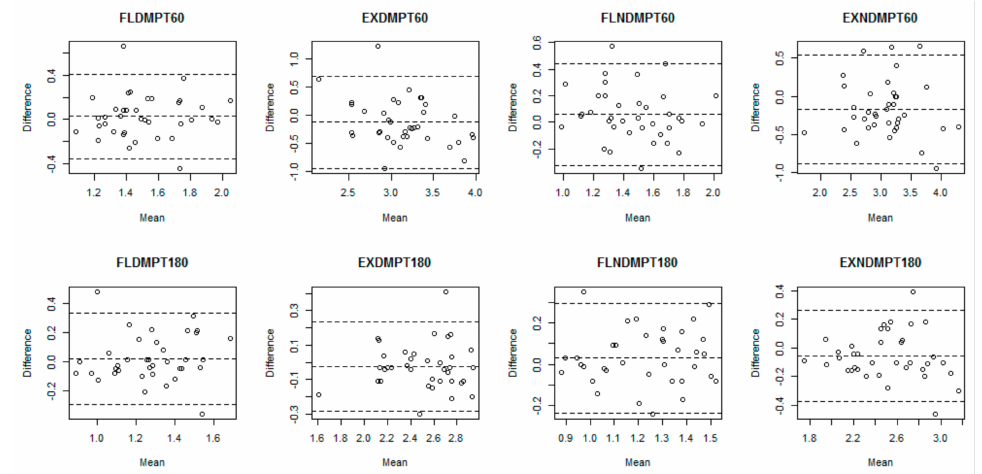
Figure 4. Bland–Altman plots for the inter-rater reliability of Trial 2 based on the mean of two dynamometers in eight measures. The first dashed line represents Mean–1.96 × SD, the second dashed line represents Mean, and the third dashed line represents Mean + 1.96 × SD. The grey circles indicate differences beyond the 95% confidence